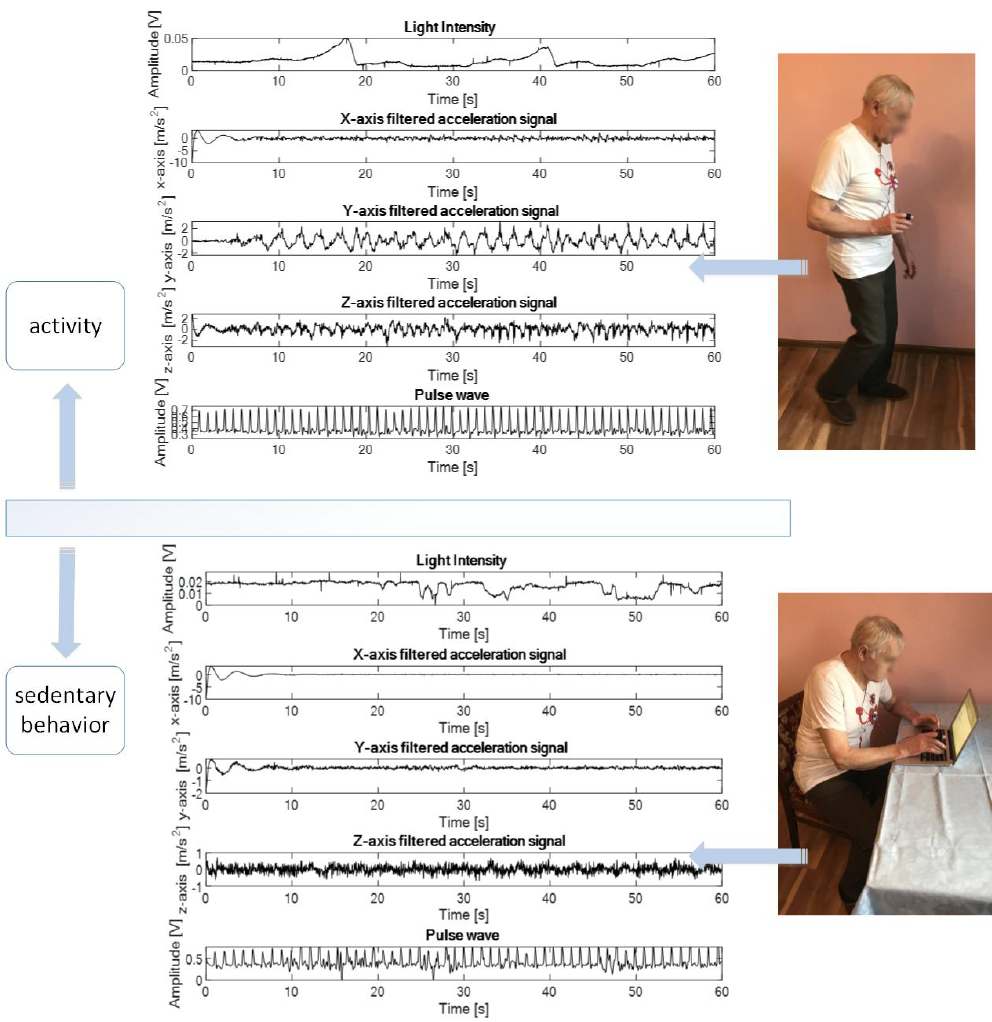
Figure 5. The diagram displays volunteer while walking and sitting and the plot of light intensity, acceleration, and pulse wave sensor data as well as output from classification model.